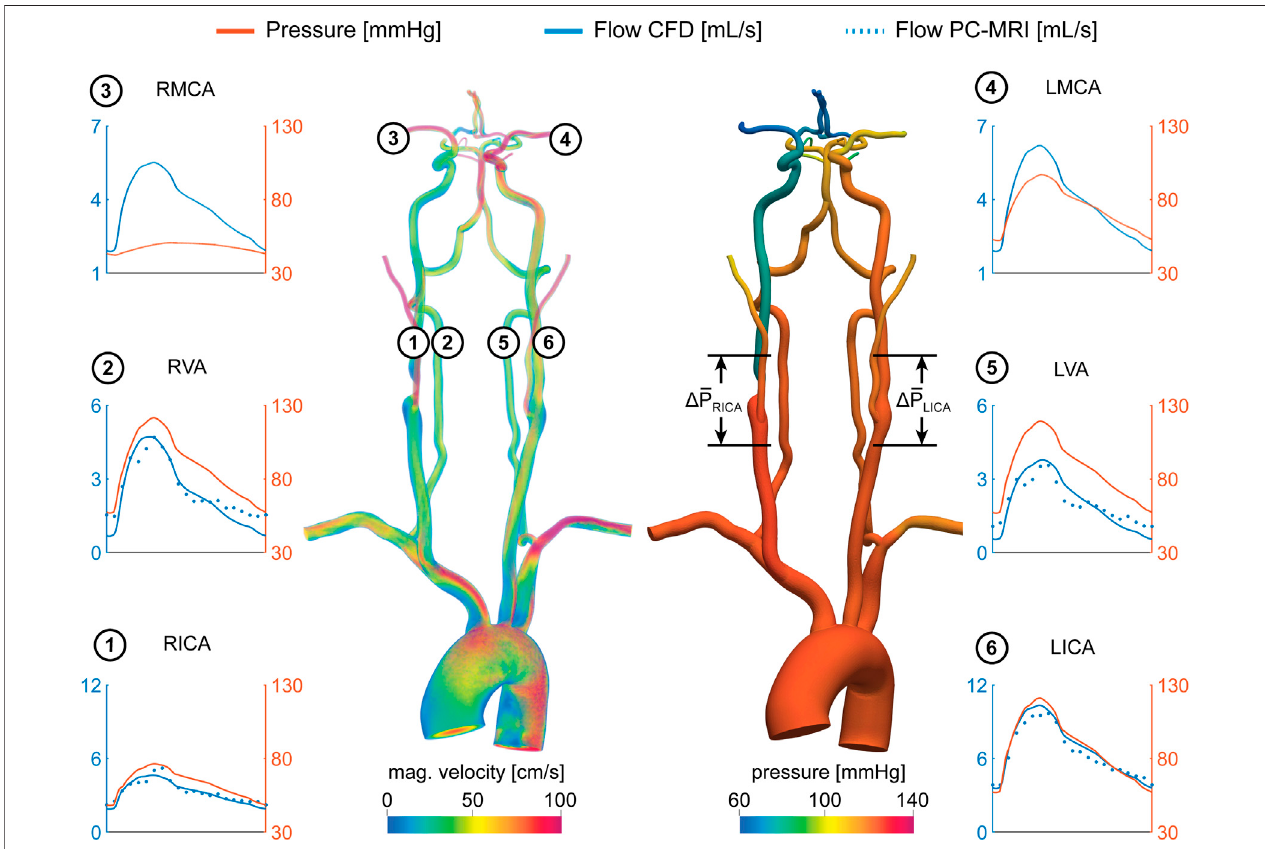
FIGURE 7 | Velocity and pressure fi elds at peak systole for patient 1. Flow and pressure waveforms are evaluated in the internal carotid (ICA), vertebral (VA), and middle cerebral arteries (MCA). The fl ow waveforms in the neck arteries are compared to PC-MRI measurements above the carotid bifurcation (dotted lines). The mean pressure drop Δ P ̅ (cid:1) P ̅ prox − P ̅ dist was calculated over the RICA stenosis and the same vessel segment in the